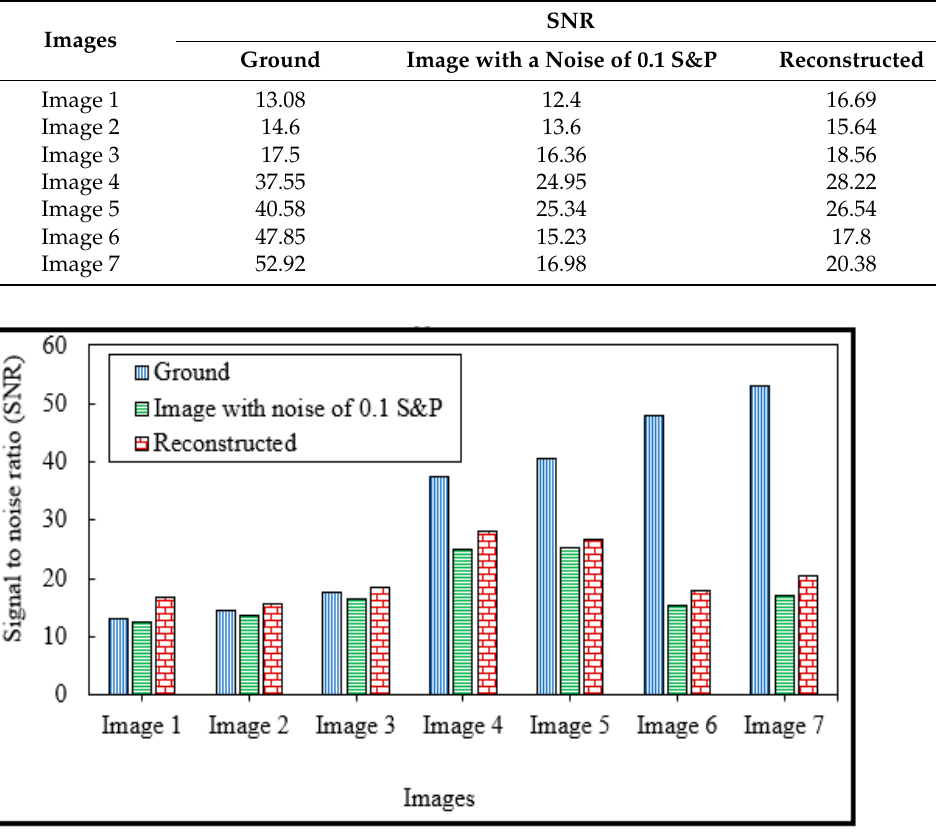
Table 3. Comparison of SNR of Images.